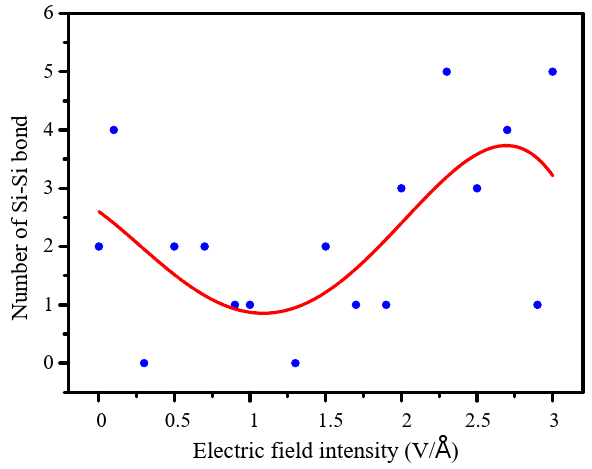
Figure 8. The number of -Si-Si- bond.